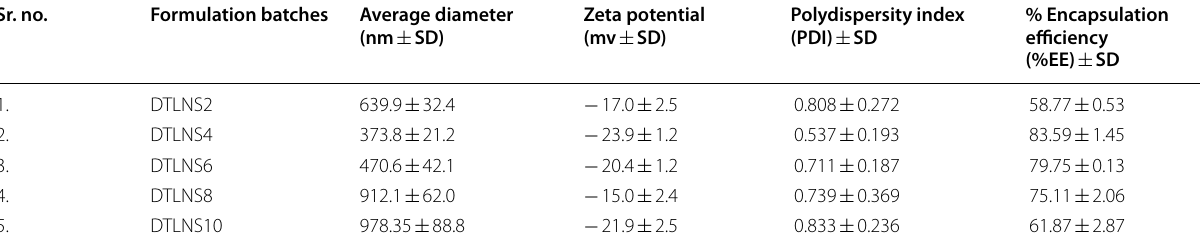
Table 2 Particle size, zeta potential (ZP), polydispersity index (PDI) and % encapsulation efficiency (%EE) of dithranol nanosponges ( n 3, mean SD) = ± Sr. no.